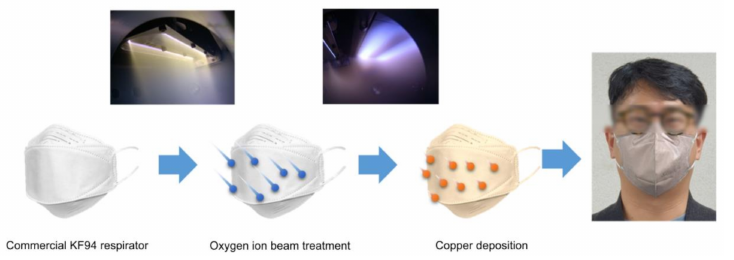
Figure 1. Copper-coated KF94 mask fabricated via vacuum surface treatments, including oxygen ion beam irradiation and copper sputtering deposition.